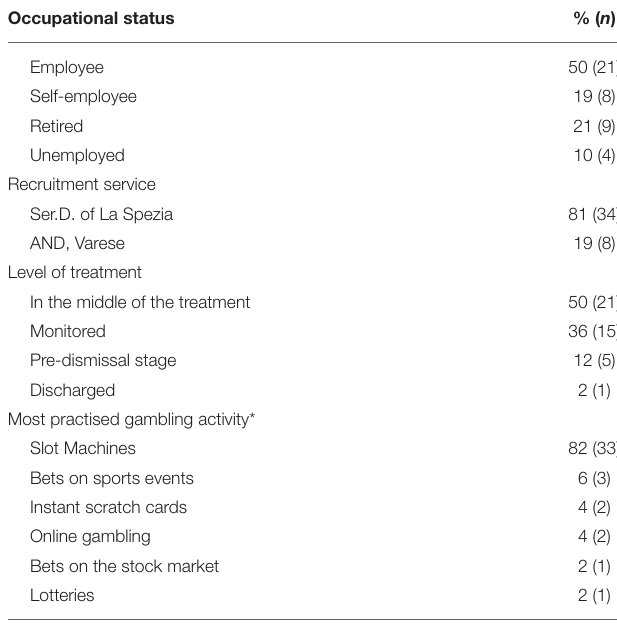
TABLE 1 | Affected family members’ educational level, occupational status, marital status, kindship with the gambler and gambler’s recruitment service. Educational level